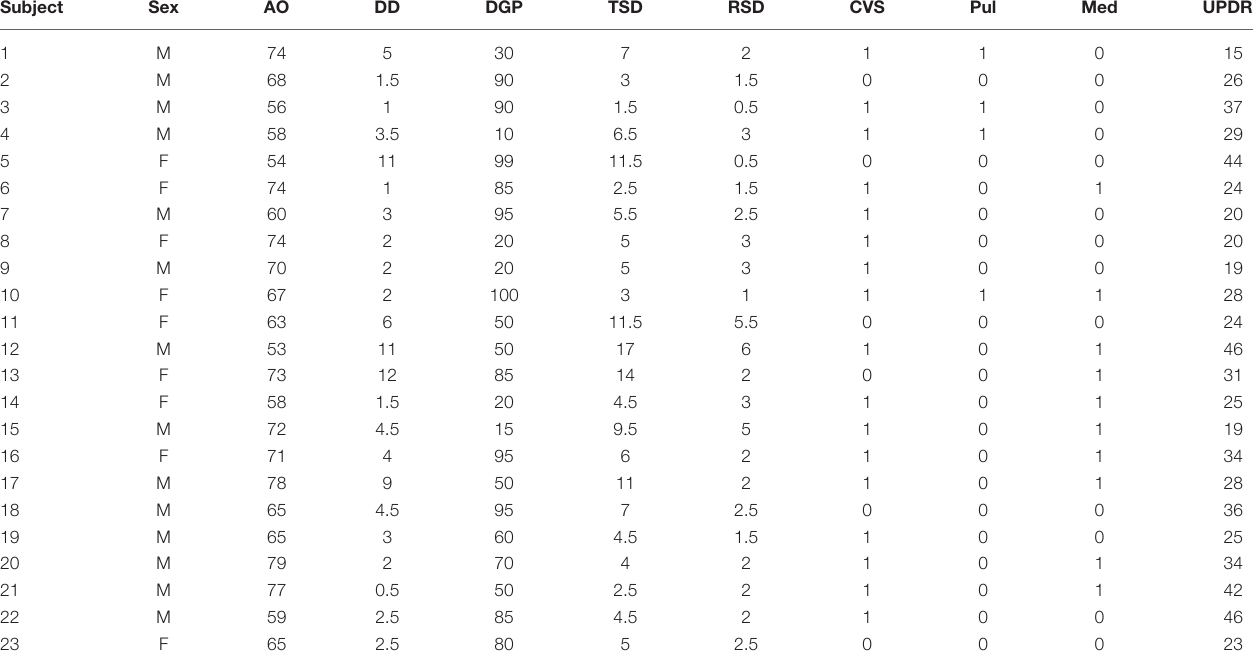
TABLE 1 | Characteristics of the PSP